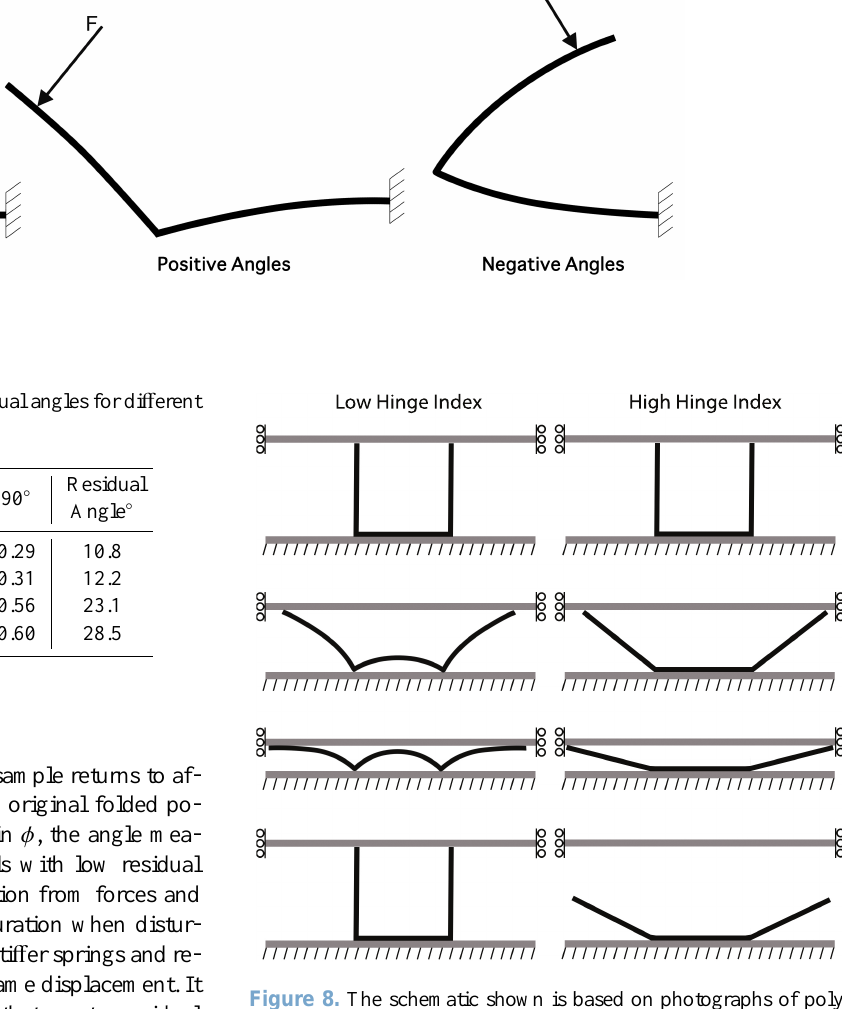
Figure 8. The schematic shown is based on photographs of poly- carbonate (left) and fibrous paper (right) samples placed in a vice and compressed. Unlike previous samples, these samples each have a “U” shape that is formed by two 90 degree creases. Left side: low hinge index indicating panel warping, right side: fibrous paper or high hinge index indicating crease acting as a